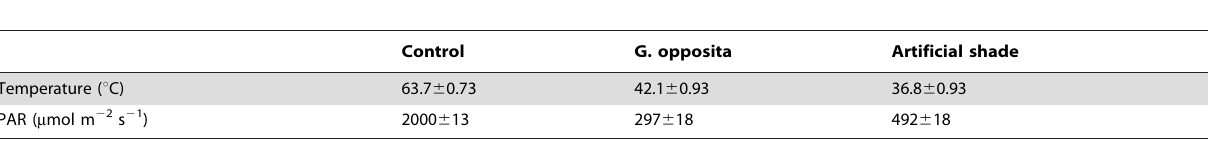
Table 2. Soil temperature and PAR (mean 6 1 SE) during the noon period on December 23, 2012 in the control (open microsites), under a Guapira opposita crown and under artificial shade